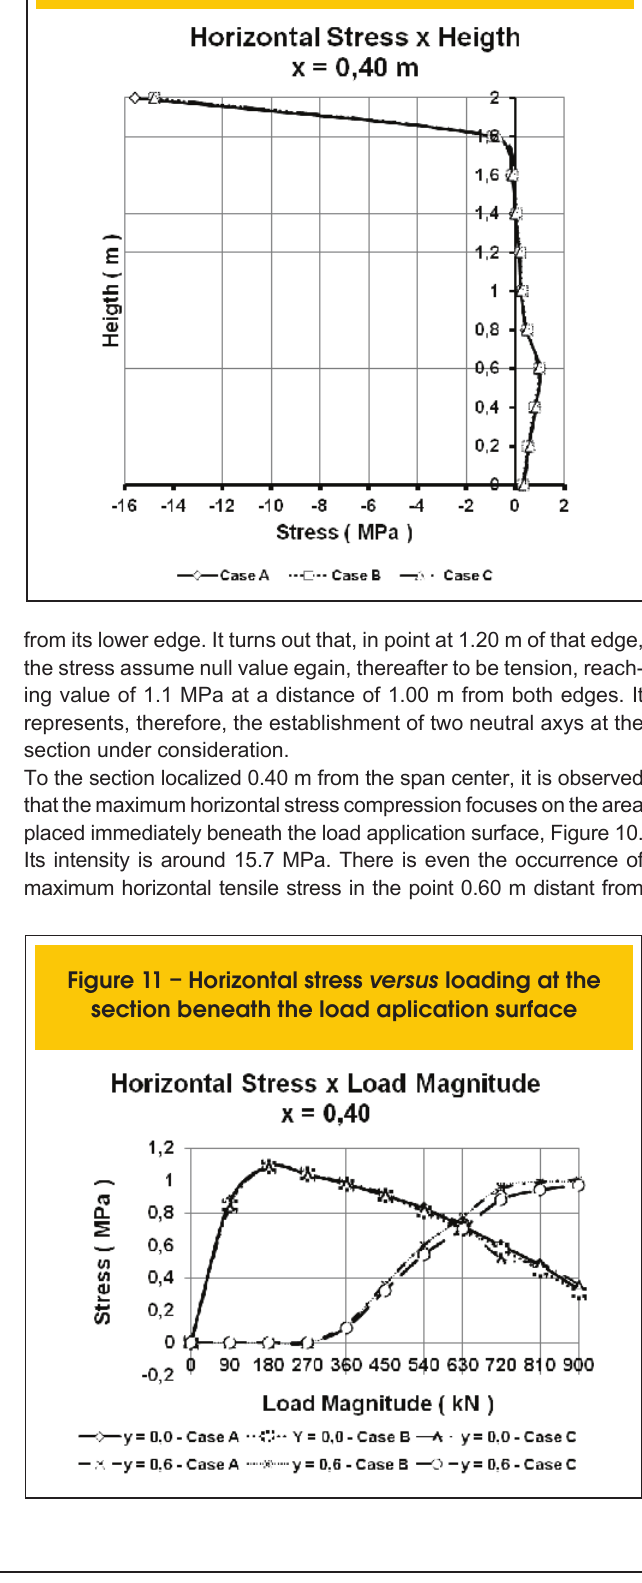
Figure 10 – Horizontal stress versus heigth at the section beneath the load aplication surface